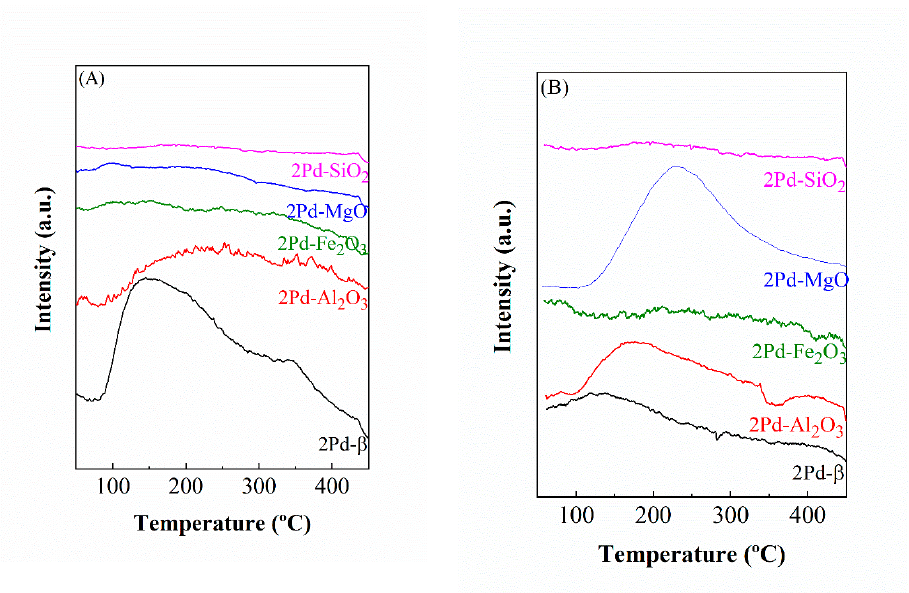
Figure 5. NH 3 -TPD ( A ) and CO 2 -TPD ( B ) for Pd-based catalysts with 2 wt.% Pd. Table 2. Amount of acid sites, estimated by NH 3 -TPD, and basic sites, deduced from CO 2 -TPD, of Pd-based catalysts with 2 wt.%